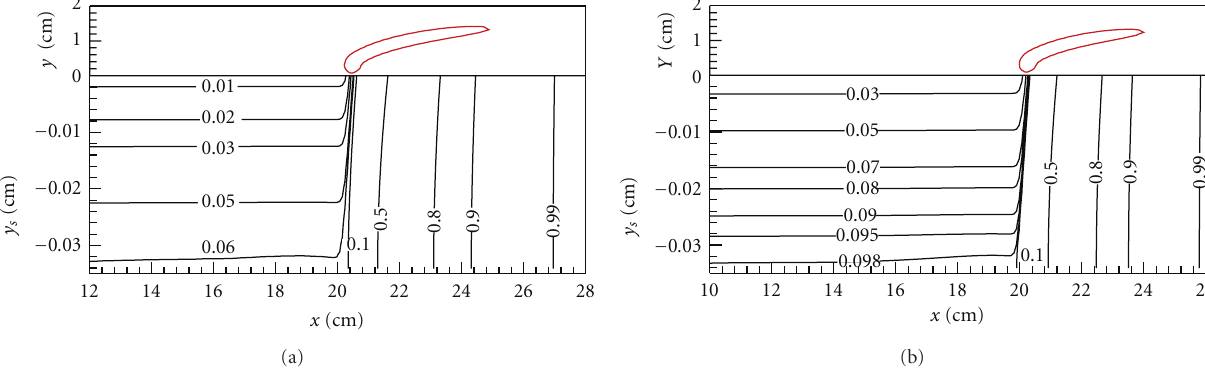
have the same features for both models. However, the